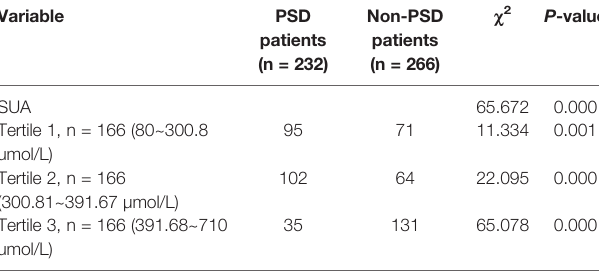
TABLE 2 | Clinical and demographic characteristics of patients with PSD and non-PSD.